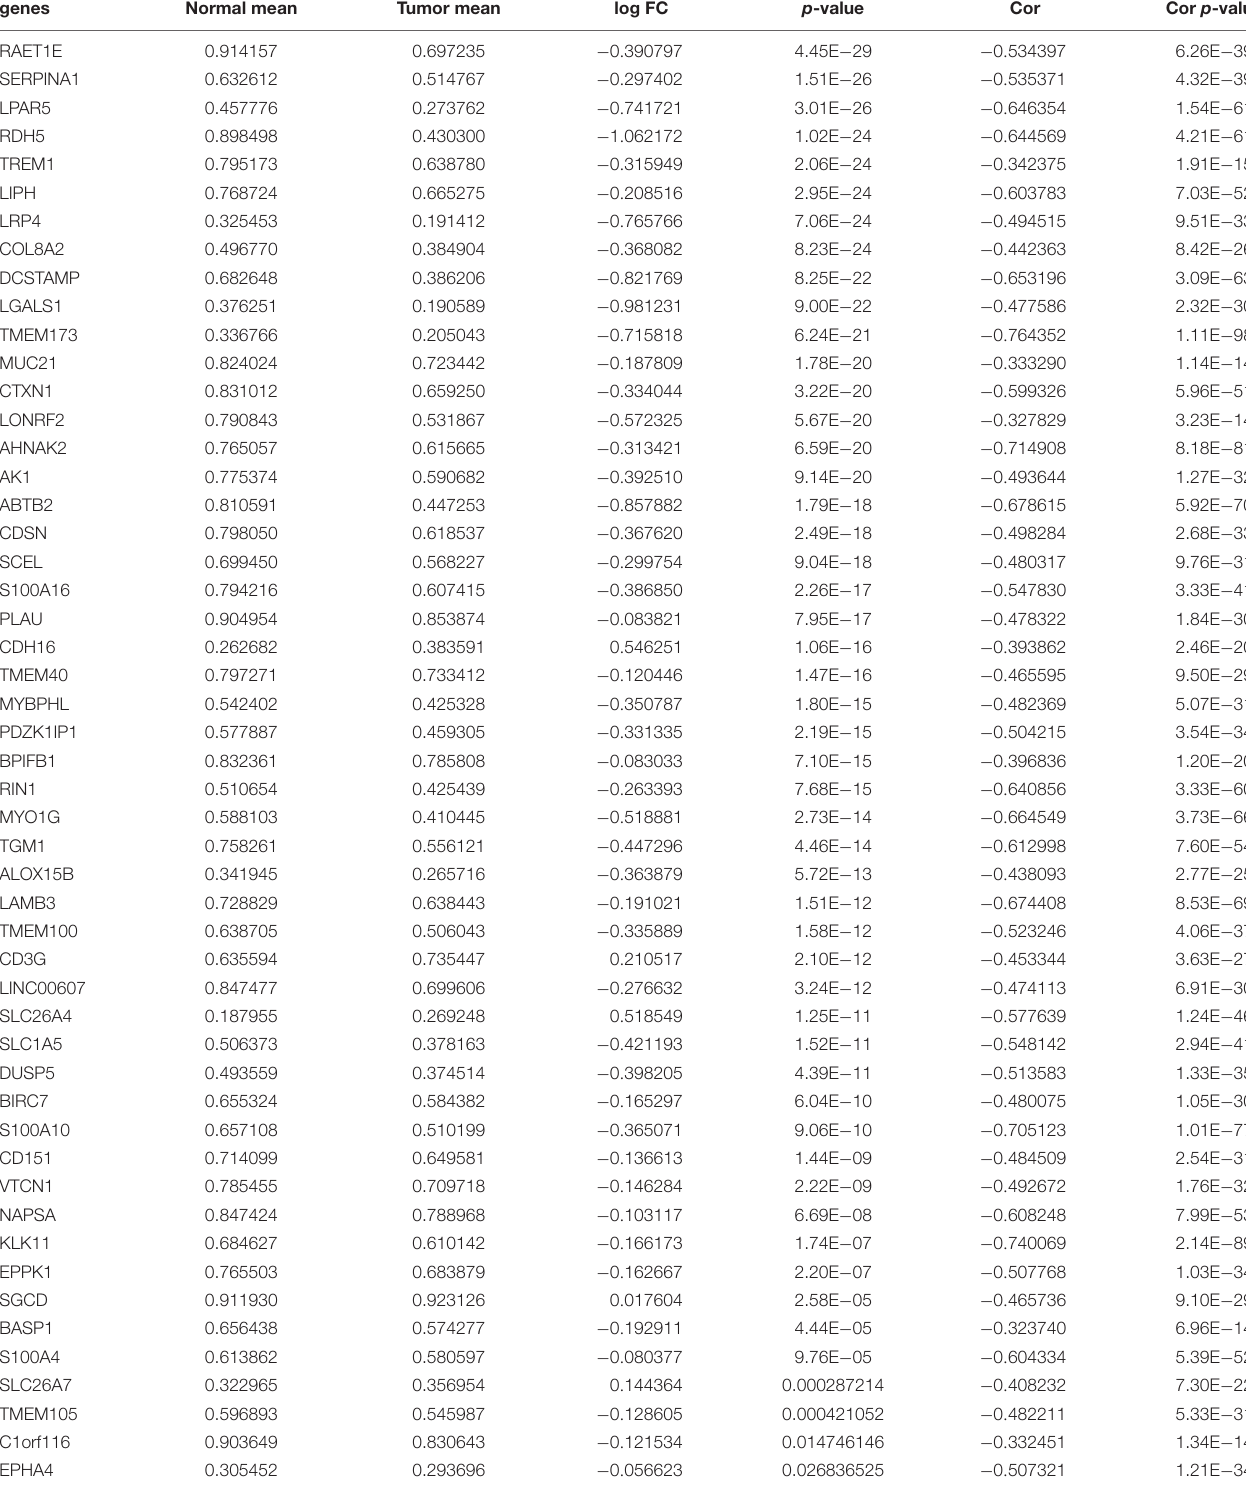
TABLE 1 | Methylation-driven